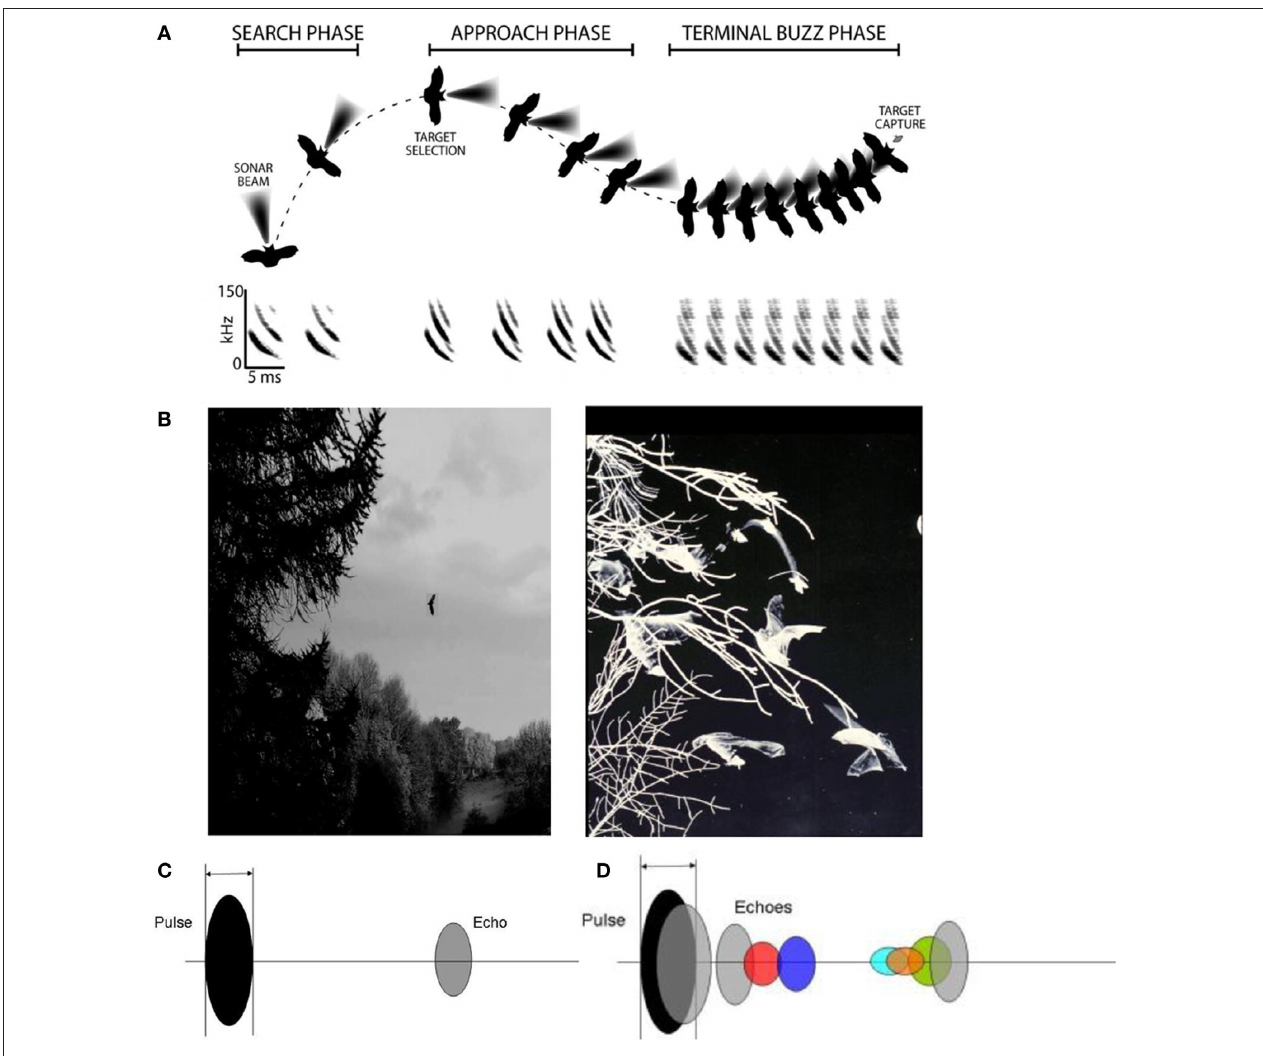
spectrograms of typical FM echolocation signals produced by the big brown bat, Eptesicus fuscus , at each of the phases of insect pursuit. The lower panels illustrate that a bat hunting insects out in the open sky, where all other objects are far away, will often encounter fairly “clean” echo returns from isolated objects, whereas a bat hunting close to vegetation will encounter a far more complex auditory scene composed of echoes from many objects arriving at different delays and